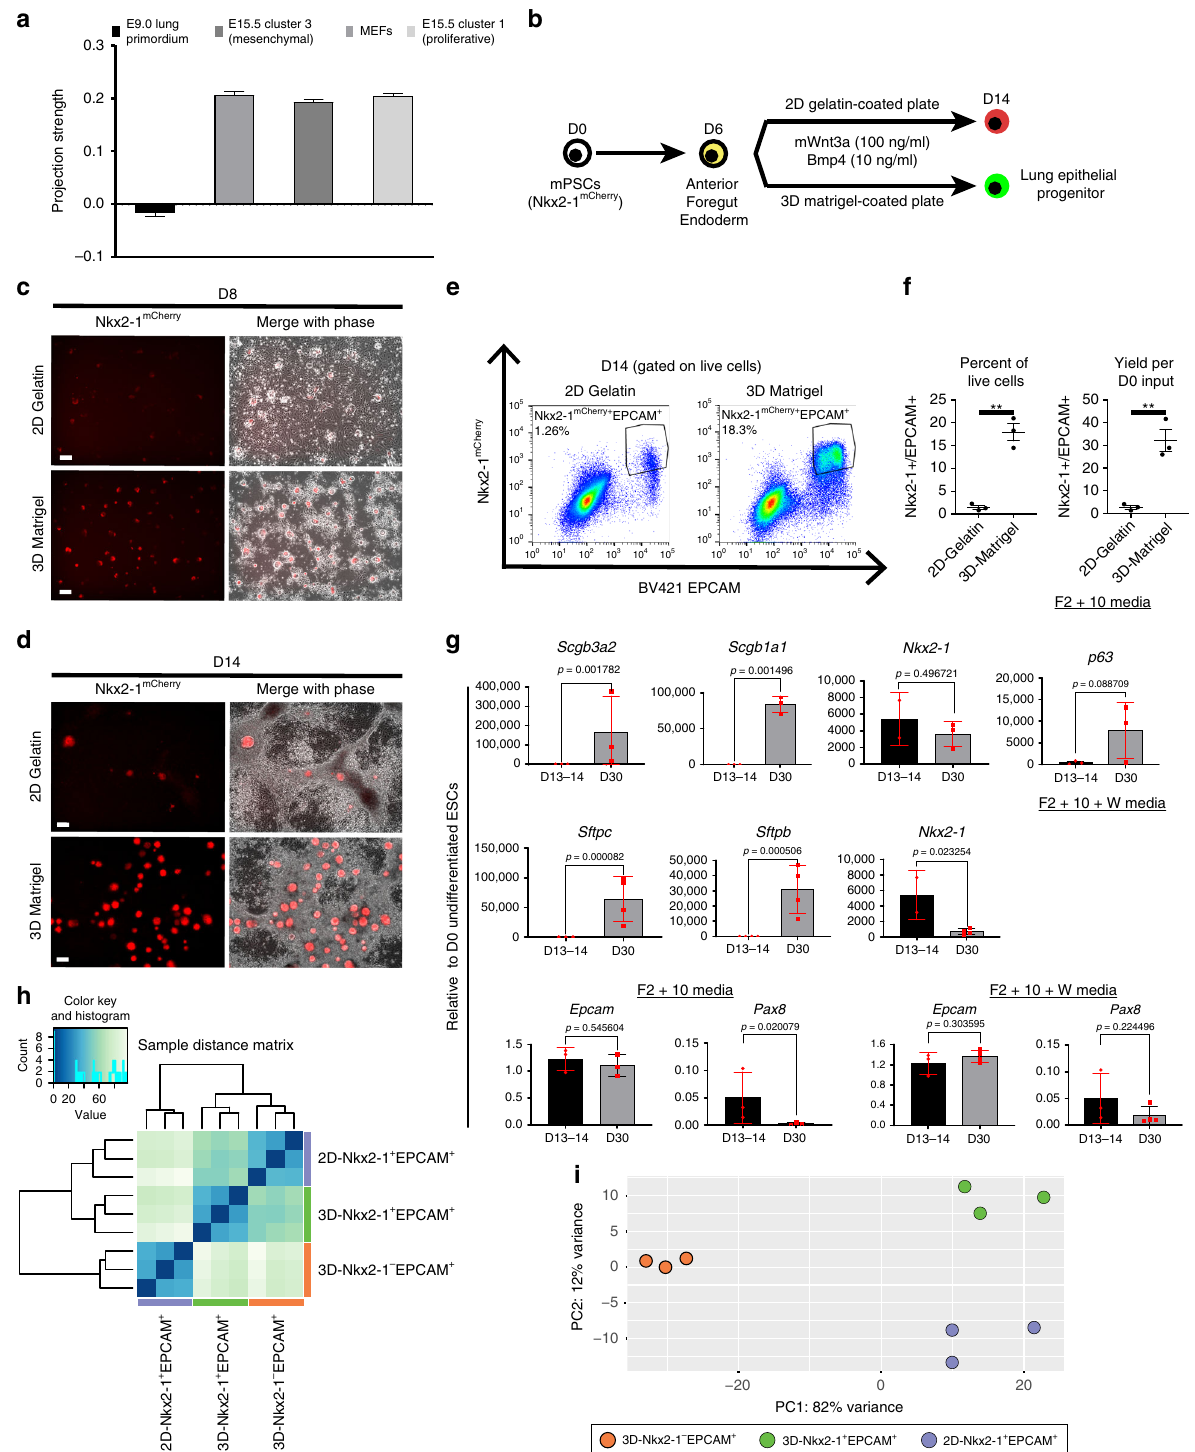
D7, and D14 from Dame et al. 43 ) with high projections on undifferentiated ESC and E8.25 ectoderm for D1 cells and high E13.5 thyroid projection for D14 cells. Similarly, a reduction of the MEF score and increases in E9.0 Lung Primordium and E8.25 Foregut Endoderm scores was observed in all EPCAM + popula- tions whereas the 3D-Nkx2-1 - EPCAM + population also showed an increased liver score (Fig.